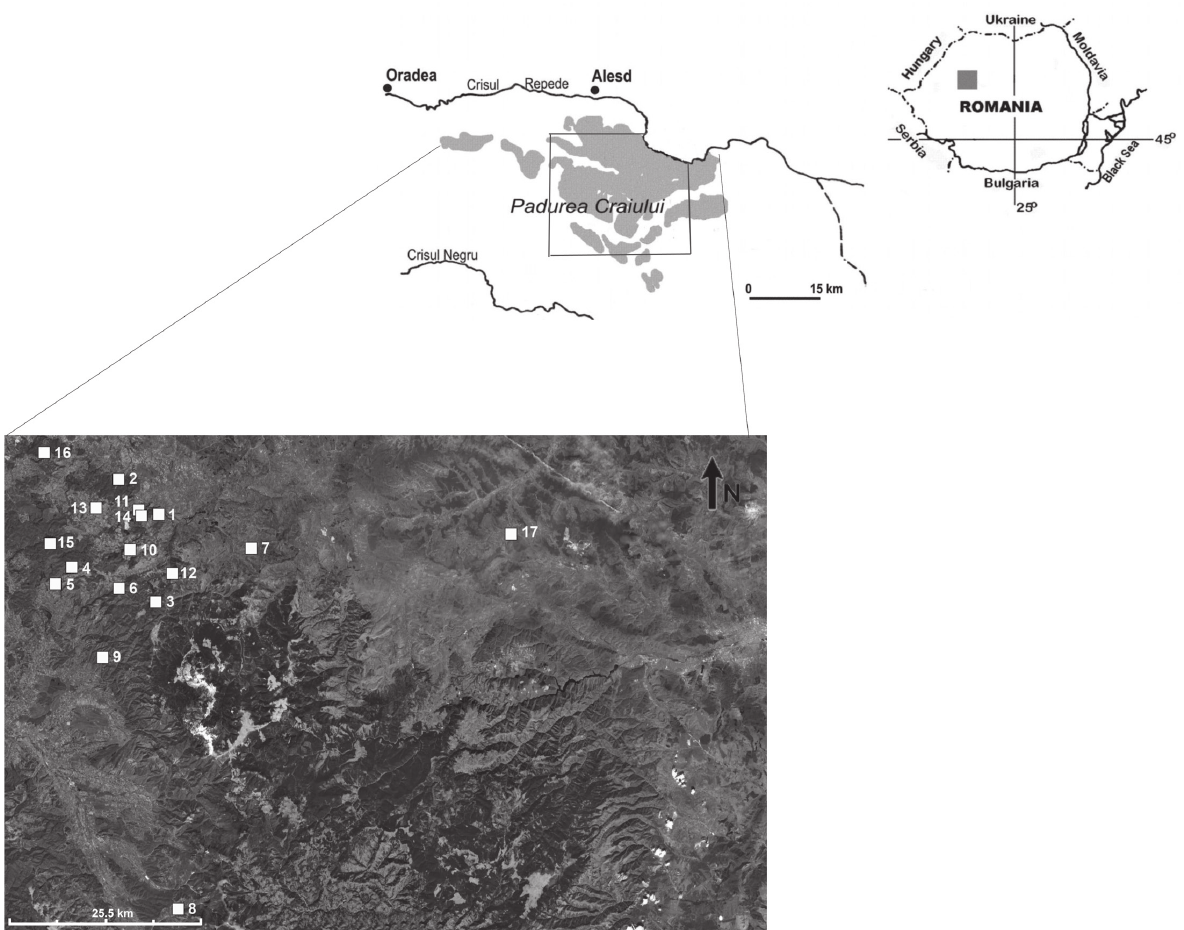
Figure 1 - Location of investigated caves in the Pădurea Craiului Mountains (north-western Romania): 1. UC; 2. VC; 3. LC; 4. CC; 5. DC; 6. Întorsuri Cave; 7. Săncuta Cave; 8. Cubleş Cave; 9. Meziad Cave; 10. Moanei Cave; 11. Vântului Cave; 13. Fanului Cave; Bătrânului Cave; 14. Napiştileu Cave; 15. Vizu Cave; 16. Igriţa cave; Gălăşeni